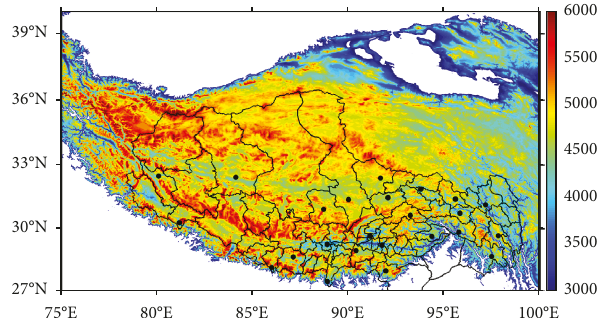
Figure 1: Distribution of lightning observation sites on the QTP (black dots) and the elevation of the region (color